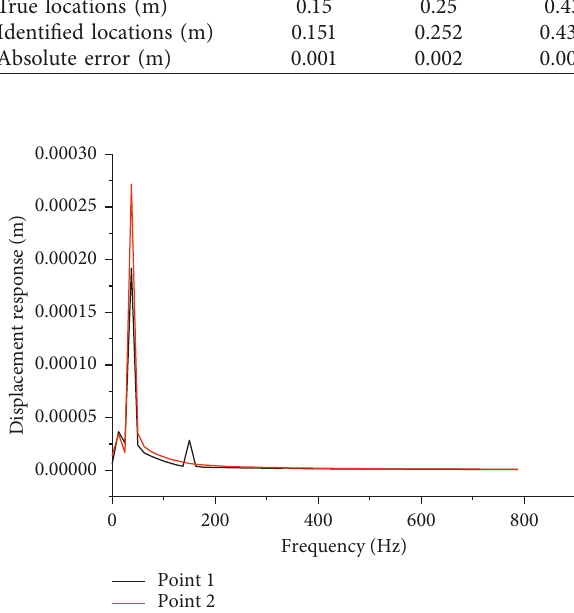
Figure 15: FRF of the displacement responses by impact A.